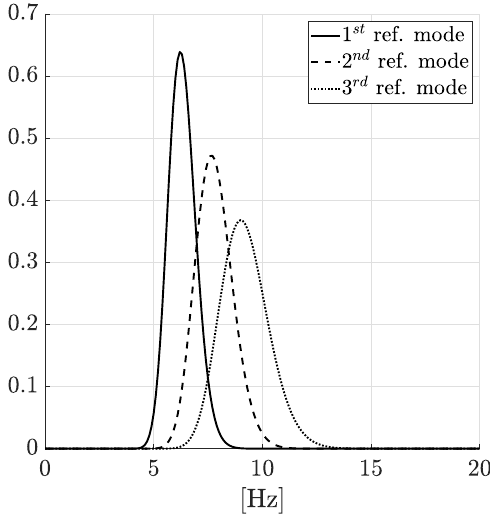
Figure 5. Distributions of the first three frequencies of the